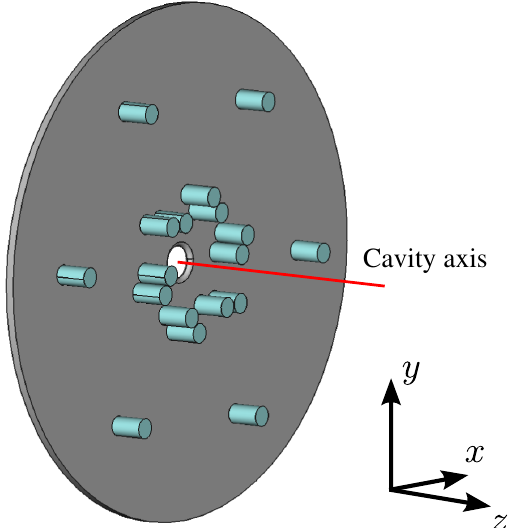
FIG. 11. An optimized hybrid PhC cavity (Opt-18-Sapphire) reduces the number of rods required to confine the accelerat- ing mode.